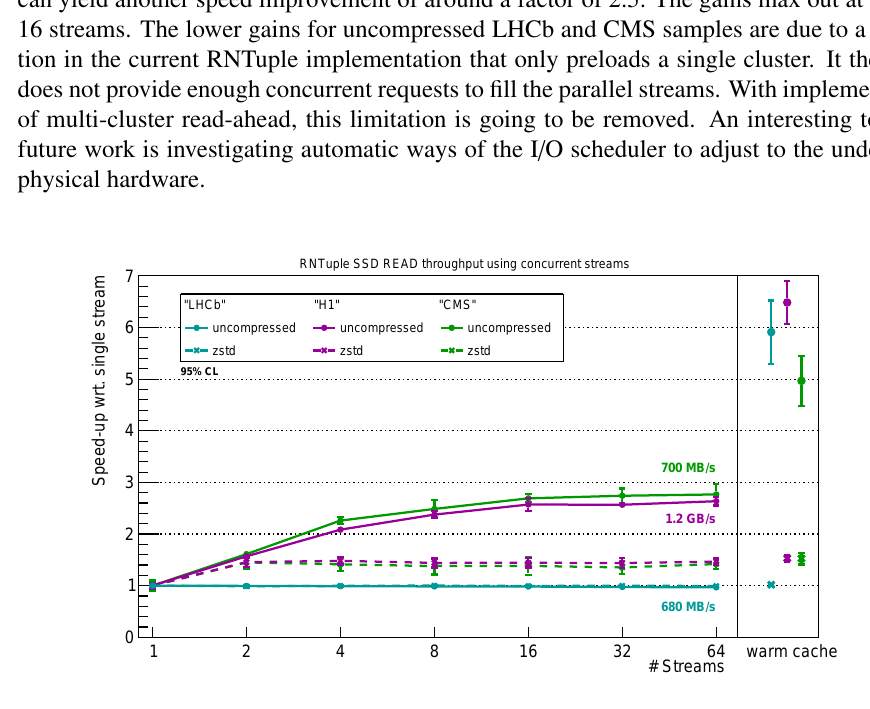
Figure 7. Full exploitation of SSDs by concurrent streams on machine 1. For comparison, the right hand side repeats the warm cache results from Figure 5. Single stream performance is identical to the SSD / zstd results in Figure